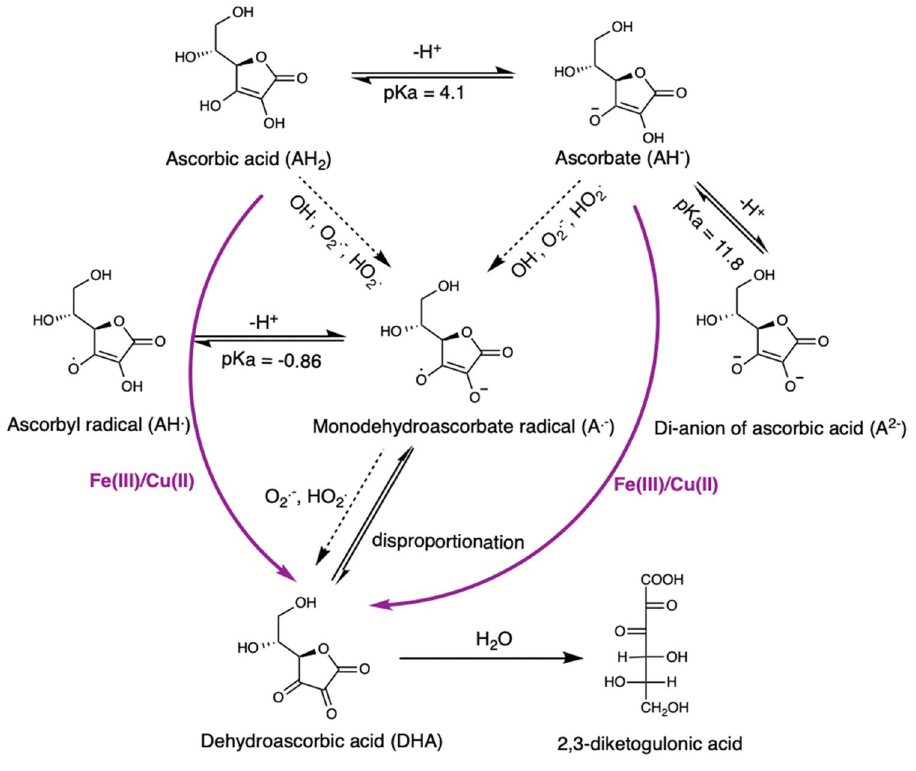
Figure 1. Ascorbic acid oxidation